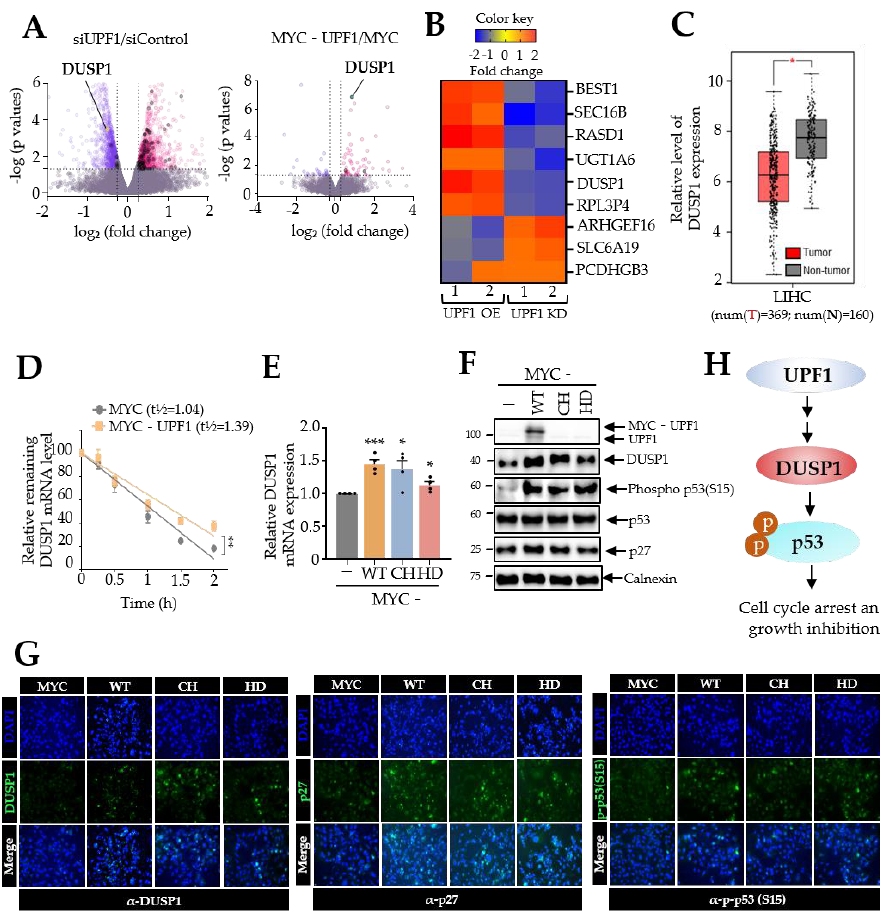
Figure 4. UPF1 regulates DUSP1 at the posttranscriptional level. ( A ) Volcano plot showing the log2 fold change in expression between UPF1-overexpressing/UPF1-depleted and control-transfected cells. The horizontal line indicates the significance threshold ( p < 0.05; n = 2). The black dots represent endogenous NMD target transcripts. ( B ) Expression levels of common transcripts that were upreg- ulated and downregulated by UPF1 overexpression and UPF1 depletion, respectively, in Huh7 cells. ( C ) Validation of the mRNA expression level of DUSP1 in liver hepatocellular carcinoma (LIHC) tissues and normal liver tissues using the GEPIA database. ( D ) Huh7 cells transfected with MYC- UPF1 or MYC were treated with 100 μg /mL DRB for 2 h. The level of DUSP1 mRNA was measured at the indicated time point. The relative level of mRNA was normalized to that of GAPDH mRNA. ( E ) The level of DUSP1 mRNA in UPF1 variant-expressing Huh7 cells was measured by RT-qPCR. The level of mRNA was normalized to that of GAPDH mRNA. ( F ) Same as ( E ) except that the indi- cated proteins were evaluated by WB. ( G ) Immunofluorescence analysis was performed using Huh7 cells transfected with UPF1 variants (200× magnification). Immunofluorescence microscopy showed DUSP1, p27 and phopho-p53(S15) (green) and nuclei (blue). ( H ) The proposed model is shown. * p ≤ 0.05; ** p ≤ 0.01; *** p ≤ 0.001; ns, not significant. 4. Discussion Liver cancer has a high mortality rate worldwide compared to other malignant tu- mors. The prevailing therapy for liver cancer is treatment with tyrosine kinase inhibitors (TKIs). However, TKI treatment cannot significantly eliminate HCC tumors with drug re- sistance [28]. Thus, a new approach for liver cancer treatment is urgently needed. To dis- cover new treatments for liver cancer, we addressed the function of UPF1 in HCC. First, we demonstrated that overexpression of UPF1 inhibited the tumorigenesis of HCC cell lines including Huh7, PLC/PRF/5 and SNU-354 cells (Figures 1 and 2 and Supplementary